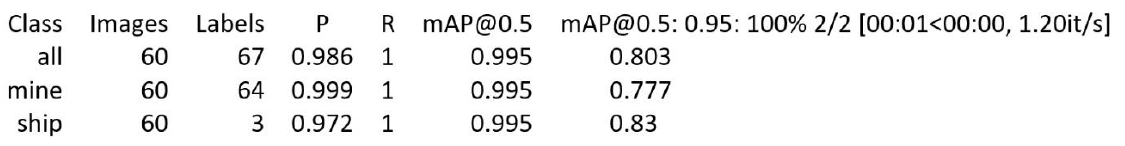
Figure 10. CVAT image annotation — naval mines for submarines.